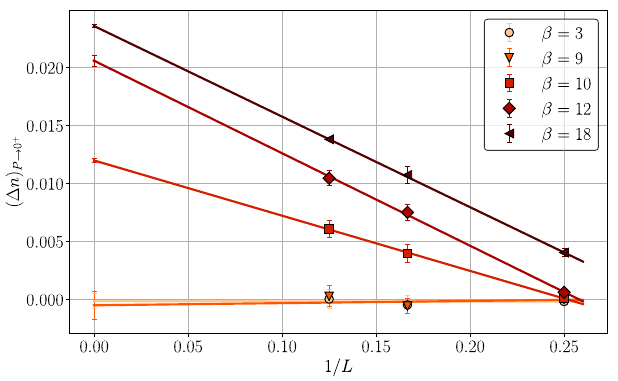
FIG. 11. Finite-size extrapolation of the charge order in Fig. 5(d). The charge order ð Δ n Þ P → 0 þ is plotted versus the inverse of transverse lattice size 1 =L y for three different system sizes N ¼ L x × L y with fixed L x ¼ 32 while varying L y ¼ 4 , 6, and 8, respectively, at five representative temperatures. The results of the linear extrapolation to 1 =L y → 0 are shown in Fig.